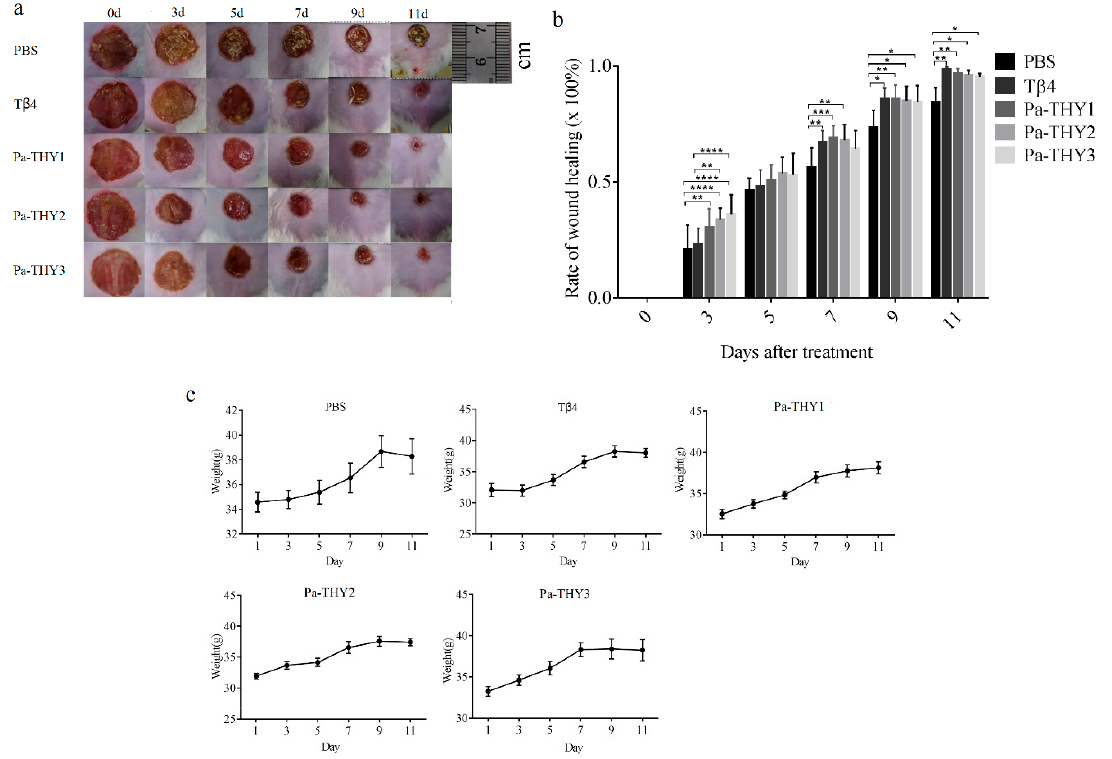
Figure 5. Effects of Pa-THYs proteins on wound healing in mouse models. ( a ) Representative images of skin wounds treated by T β 4 and Pa-THYs proteins at indicated time points (0 d, 3 d, 5 d, 7 d, 9 d, and 11 d). ( b ) Quantification data of wound-healing closure in mice treated with T β 4 and Pa-THYs proteins at indicated time points (0 d, 3 d, 5 d, 7 d, 9 d, and 11 d). * p < 0.05; ** p < 0.01; *** p < 0.001; **** p < 0.0001. ( c ) The body weight of mice treated with T β 4 and Pa-THYs proteins at indicated time points (0 d, 3 d, 5 d, 7 d, 9 d, and 11 d).